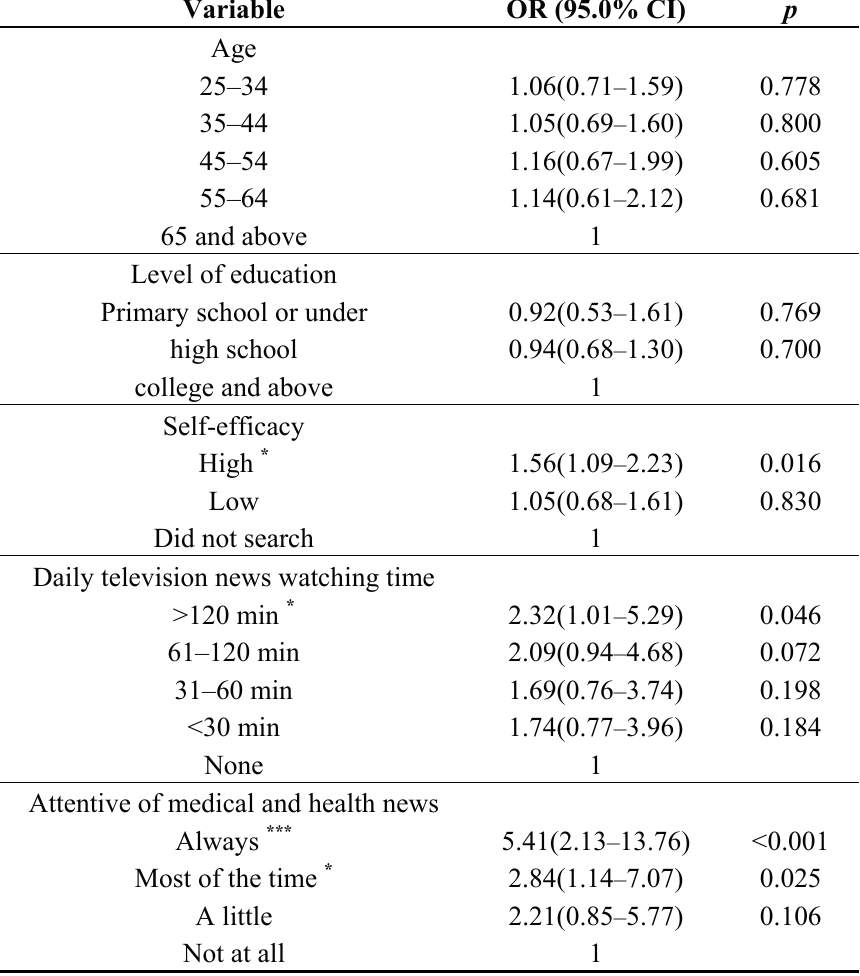
Table 3. Association between respondent characteristics and a high Health Information Score (reference group: HIS score ≤ 9) ( N =